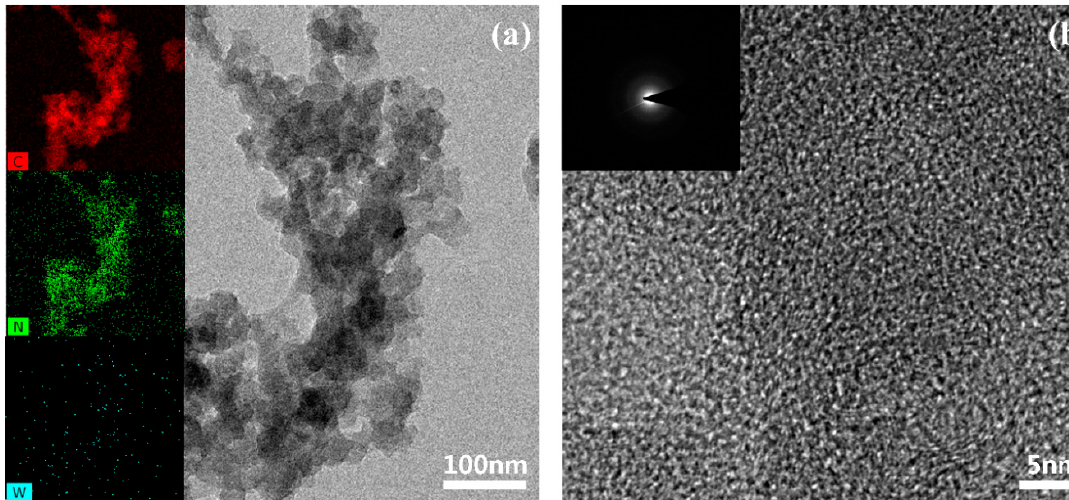
Figure 7. HR-TEM images, SAED pattern and EDS of synthesized PANI by the proposed DBD structure ( a , b ) with different magnifications of HR-TEM images; the inset of ( a ) is carbon, nitrogen and tungsten elements measured by EDS, and the inset of ( b ) is the SAED pattern.